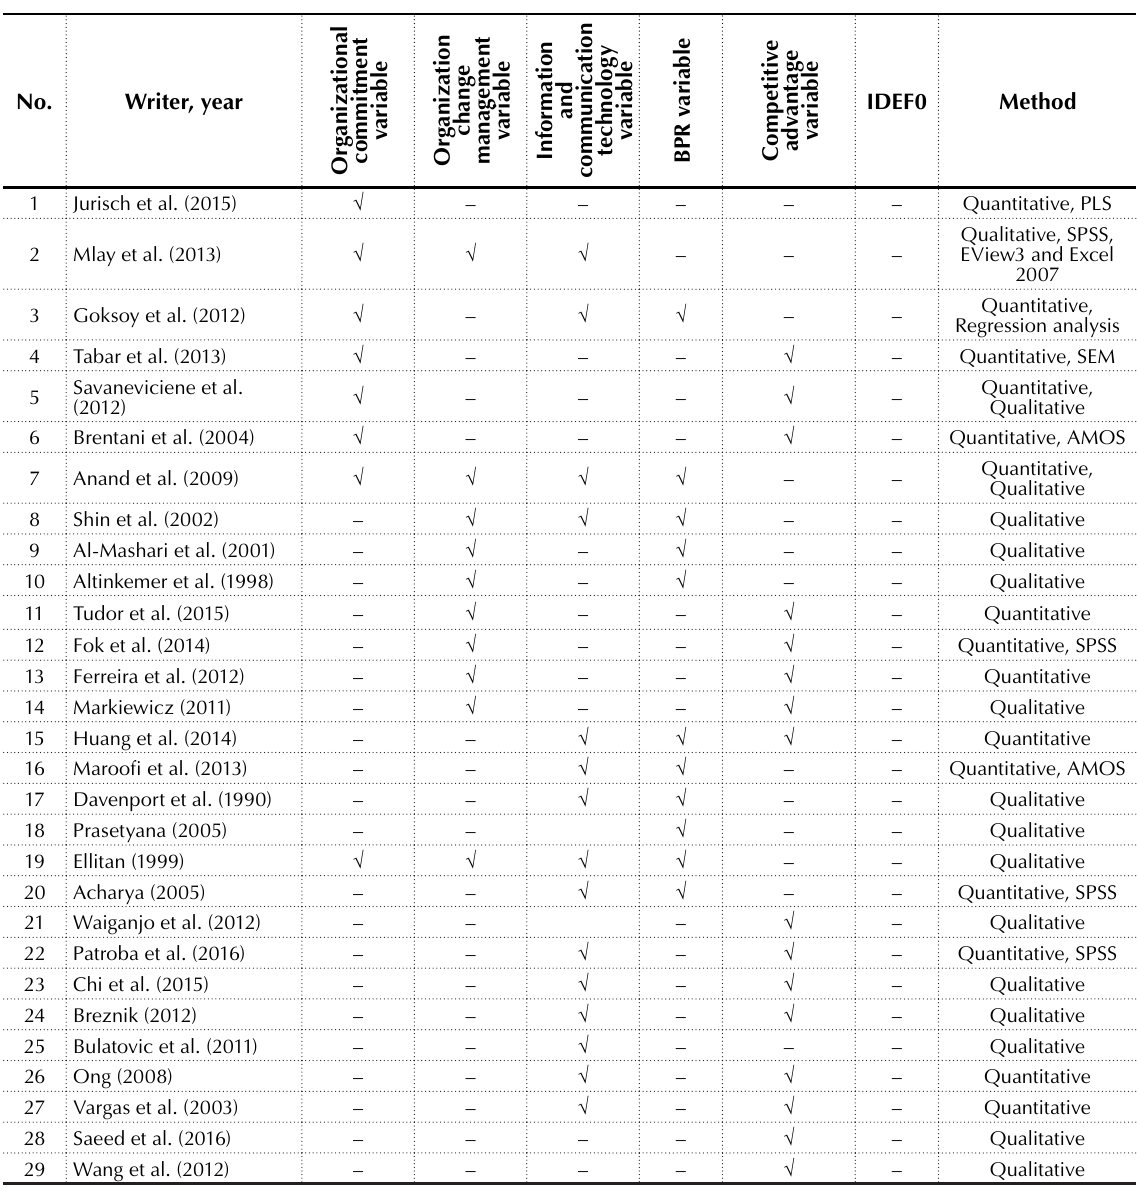
Figure 9. Business process reengineering relationship toward competitive advantage Table 1. The research of all